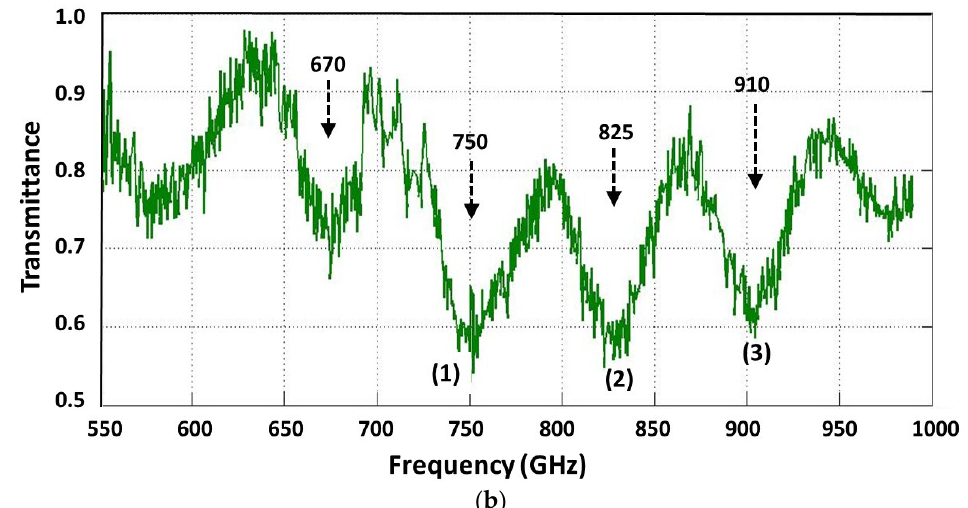
Figure 5. ( a ) Transmittance spectrum for the 50-bp DNA sample between 700 and 1050 GHz. ( b ) Transmittance for the 1-kbp DNA sample between 550 and 1000 GHz.